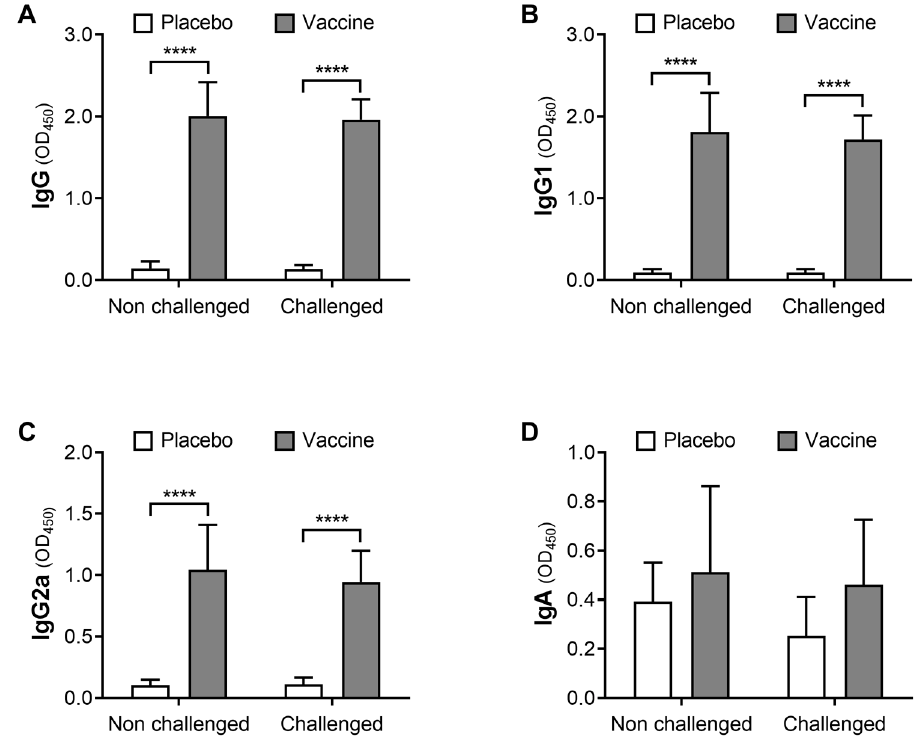
Figure 4. Proteoliposome-based vaccine increases mammary gland local levels of IgG, IgG1 and IgG2a against the bacteria. Total IgG ( A ), IgG1 ( B ), IgG2a ( C ) and IgA ( D ) immunoglobulins against E. coli were quantified in the mammary glands of vaccinated and placebo mice on day 35, by indirect ELISA assays. Results correspond to means ± SD, n = 8. **** = p < 0.0001.